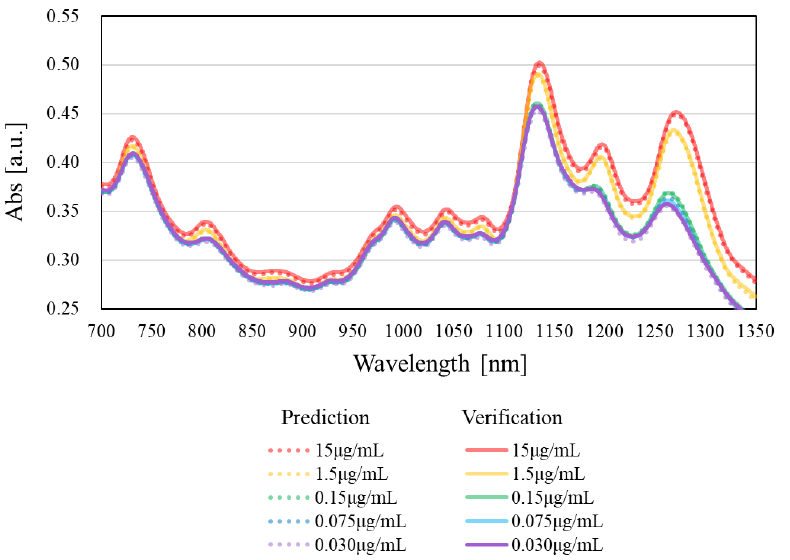
Figure 3. Comparison of the results of prediction data and verification data in the spectrum waveform after catechin addition for each catechin concentration.